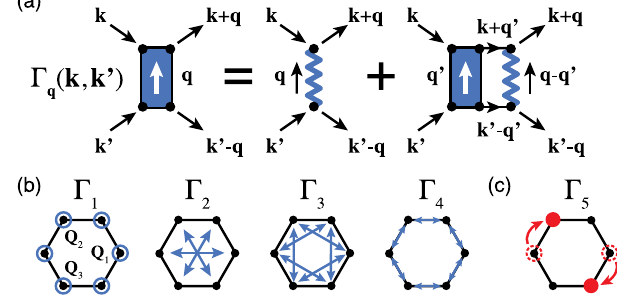
FIG. 3 (a) Effective vertex from ladder diagrams. The filled square (wavy line) represents the effective (bare) potential. (b) Diagonal and (c) off-diagonal effective interactions in the GL